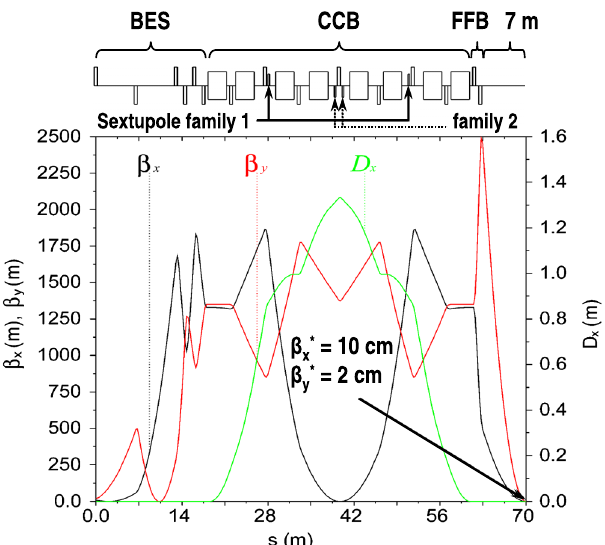
FIG. 7. Linear optics of the ion ring’s